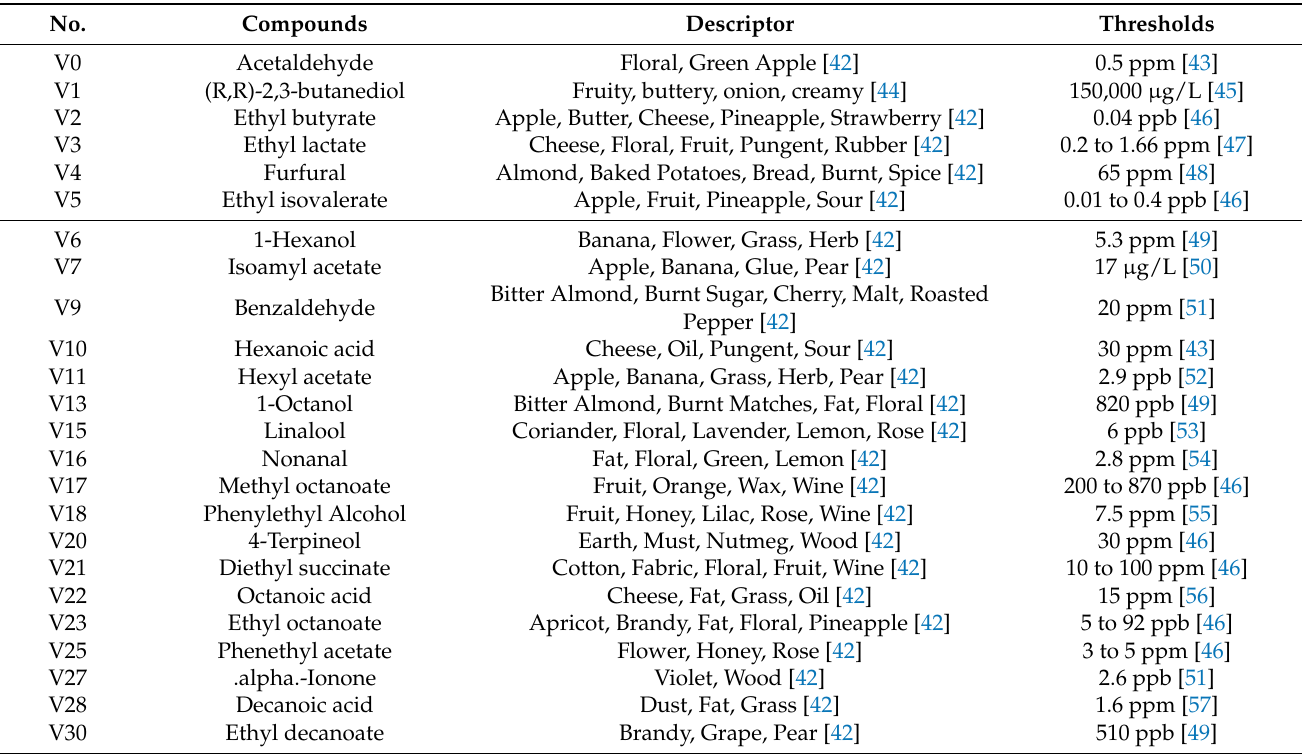
Table 5. Sensory descriptors and odor threshold values of identified volatile compounds in white wine